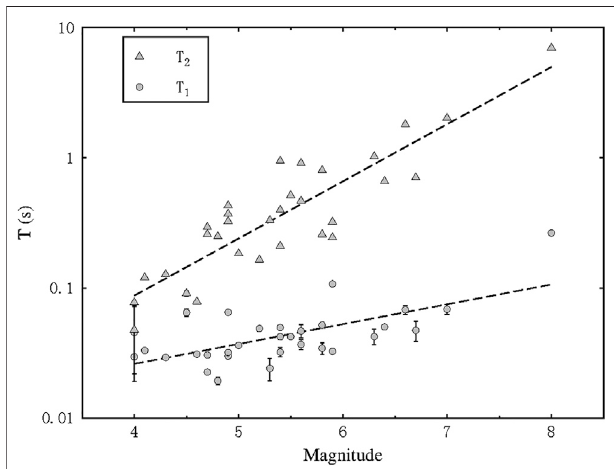
FIGURE 6 | Scaling relationship between T 1 and T 2 as a function of magnitude. Triangles and circles represent T 2 and T 1 for LPDT curves, respectively. The error bars which represent the standard deviation of the parameters fi tted by our exponential model are shown as black lines (wherevisible).Thebest fi ttinglineforeachparameterisshownasdashedline.